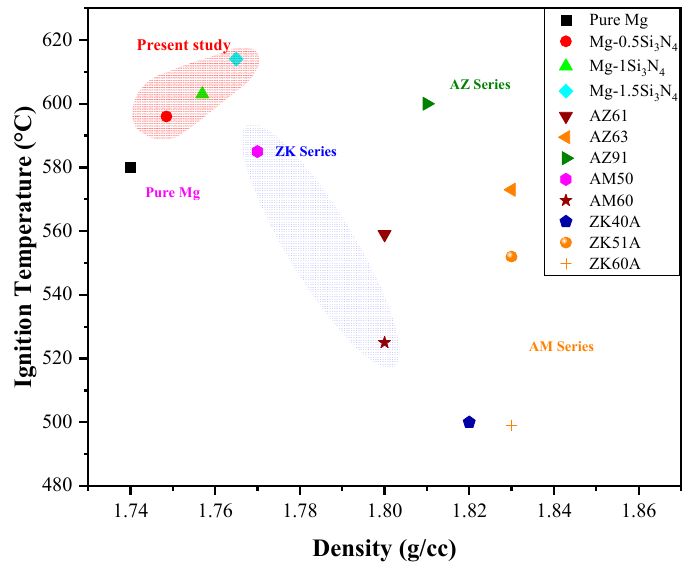
Figure 5. Ignition temperatures of widely available magnesium alloys [29], in comparison to the current study.